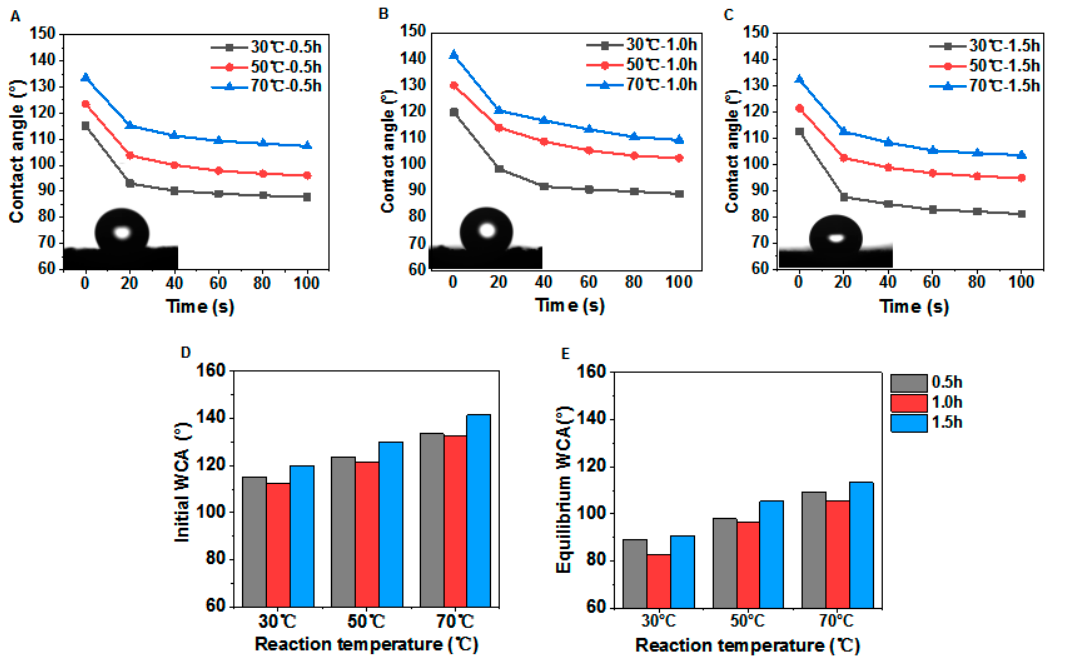
Figure 11. The water CAs of PDMS@wood on tangential section. The different reaction temperatures with durations of ( A ) 0.5 h, ( B ) 1 h, and ( C ) 1.5 h. The comparison of CAs at ( D ) initial and ( E ) equilibrium after 60 s.